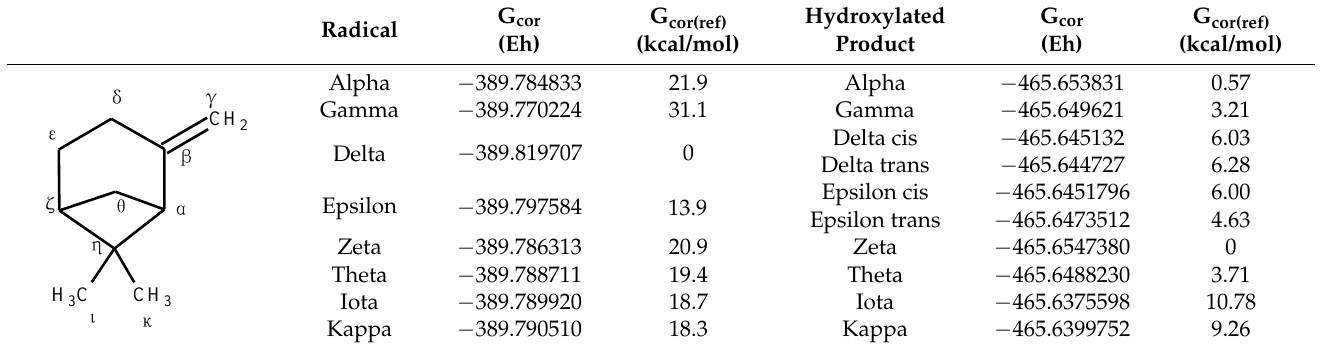
Table 2. Computed relative energies of the radicals and hydroxylated products of β -pinene. The term “cor” refers to the dispersion, BSSE, and Grimme quasi-harmonic corrections to the calculated absolute Gibbs free energies (in Hartree). Energies in kcal/mol were calculated with reference to the most stable conformation for the hydroxylated radical and product. G cor G cor(ref) Radical (Eh) (kcal/mol)